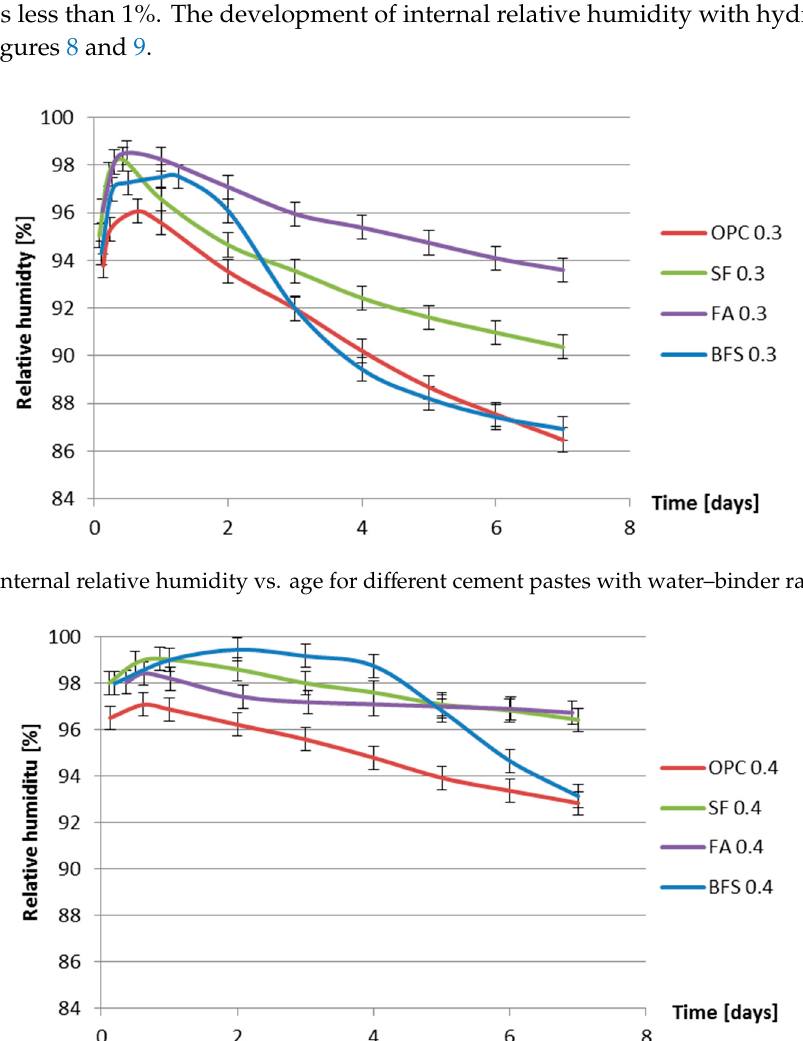
Figure 9. Internal relative humidity vs. age for different cement pastes with water–binder ratio of 0.4.